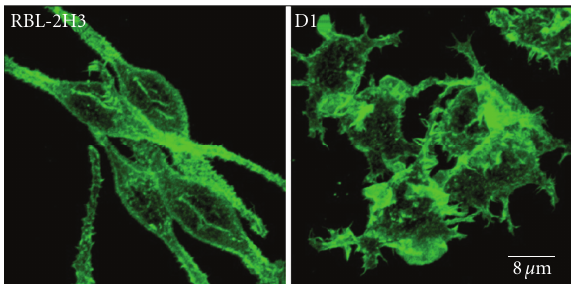
Figure 4: The F-actin distribution in RBL-2H3 and D1 cells reflects their morphology. Actin filaments in RBL-2H3 cells lie under the plasma membrane following the spindle shape of the cells and in association with microvilli. The actin cytoskeleton is altered in D1 cells and the actin filaments are concentrated in large membrane ru ffl es. The cells were fixed, permeabilized, and stained with phalloidin conjugated to Alexa 488. Samples were examined using a Leica TCS-NT laser scanning confocal